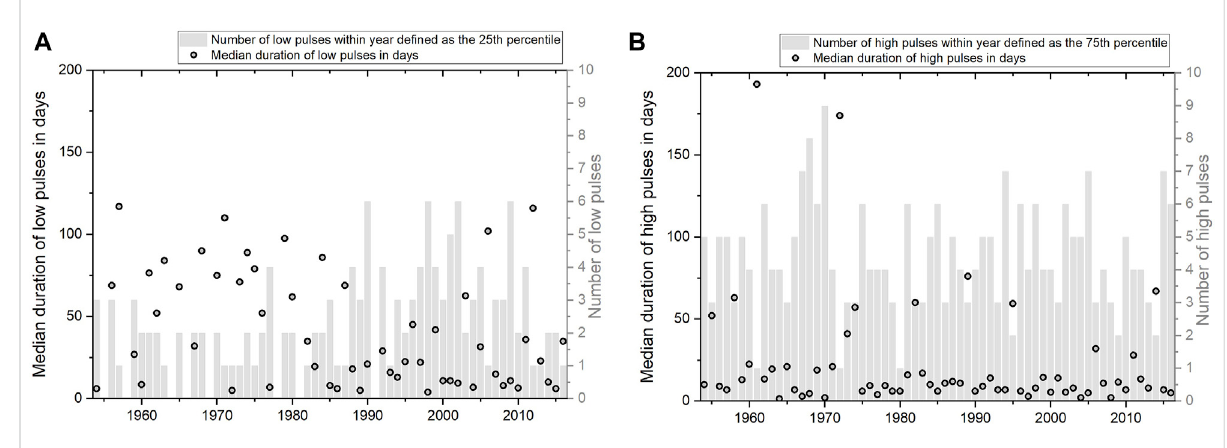
FIGURE 7 Frequency and duration of high (B) and low (A) fl ow.